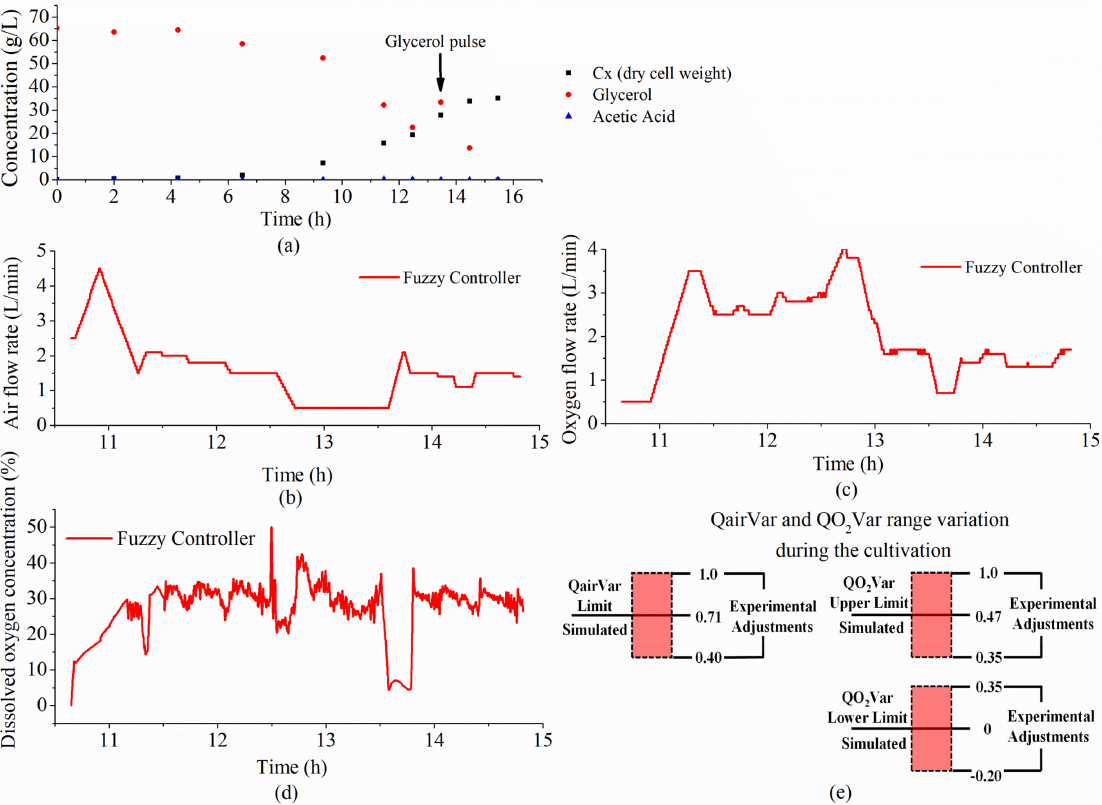
Figure 10. E. coli cultivation tests results. Fuzzy controller was activated around the 10th h. Cell mass, carbon source consumption and acetic acid production during the cultivation ( a ), dynamics of air ( b ) and oxygen ( c ) flow rates, dissolved oxygen behavior ( d ), and experimental adjustment in limits for QairVar and QO 2 Var ( e ) during the E. coli cultivation